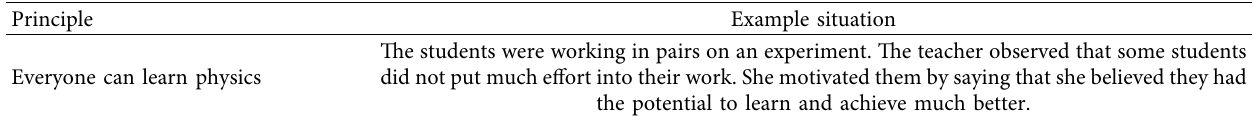
Table 2: Growth mindset feedback.